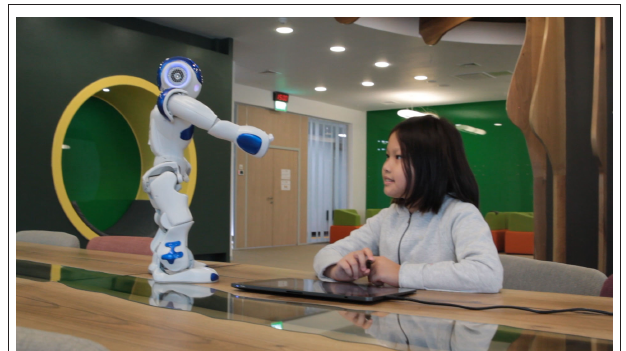
FIGURE 2 | Experimental